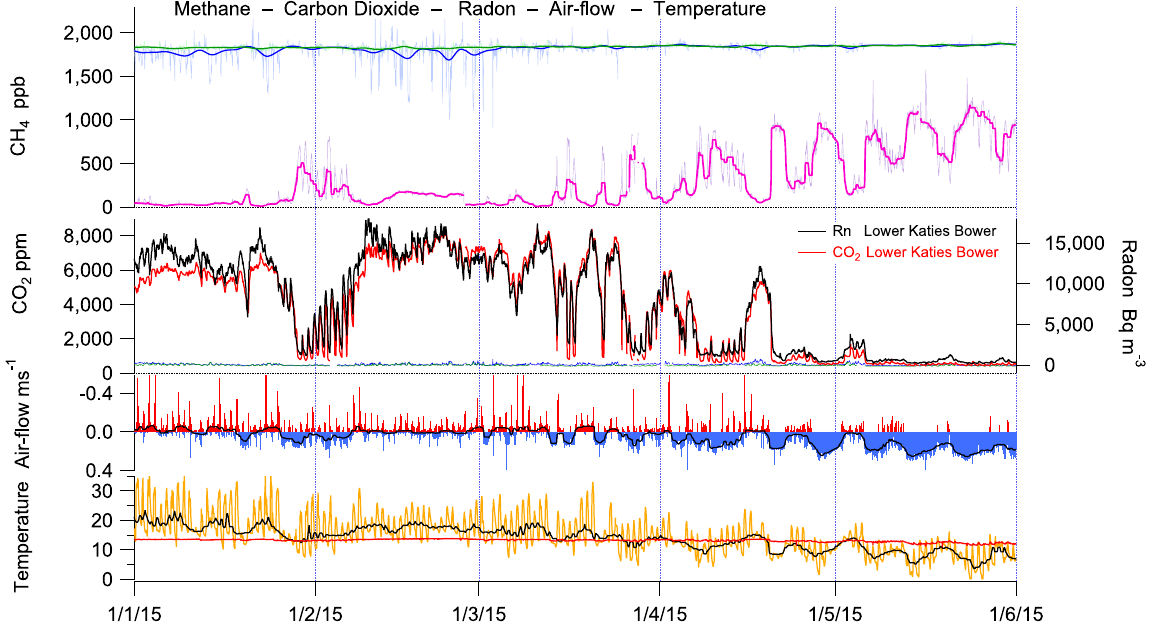
Figure 3. Chifley Cave, Lower Katies Bower trace gases CH 4 , CO 2 , and Rn, relative to cave air flow, cave and external temperature. The summer to winter period January 2015 – June 2015 illustrates the direct link between external temperature and cave CH 4 , CO 2 , and Rn through diurnal, synoptic & seasonal cycles.